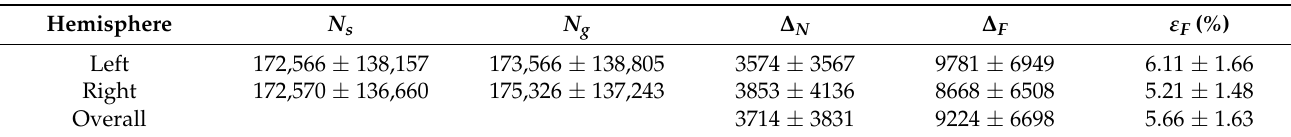
Table 4. Quantitative performance evaluation of the rat hemisphere segmentation results in the TTC-stained image dataset based on error analysis